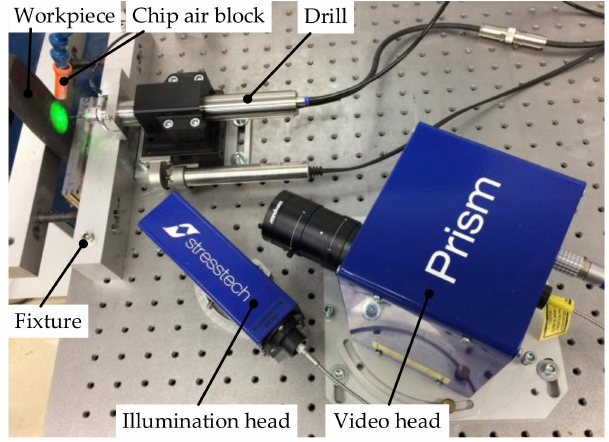
Figure 3. RS measurement arrangement (PRISM).